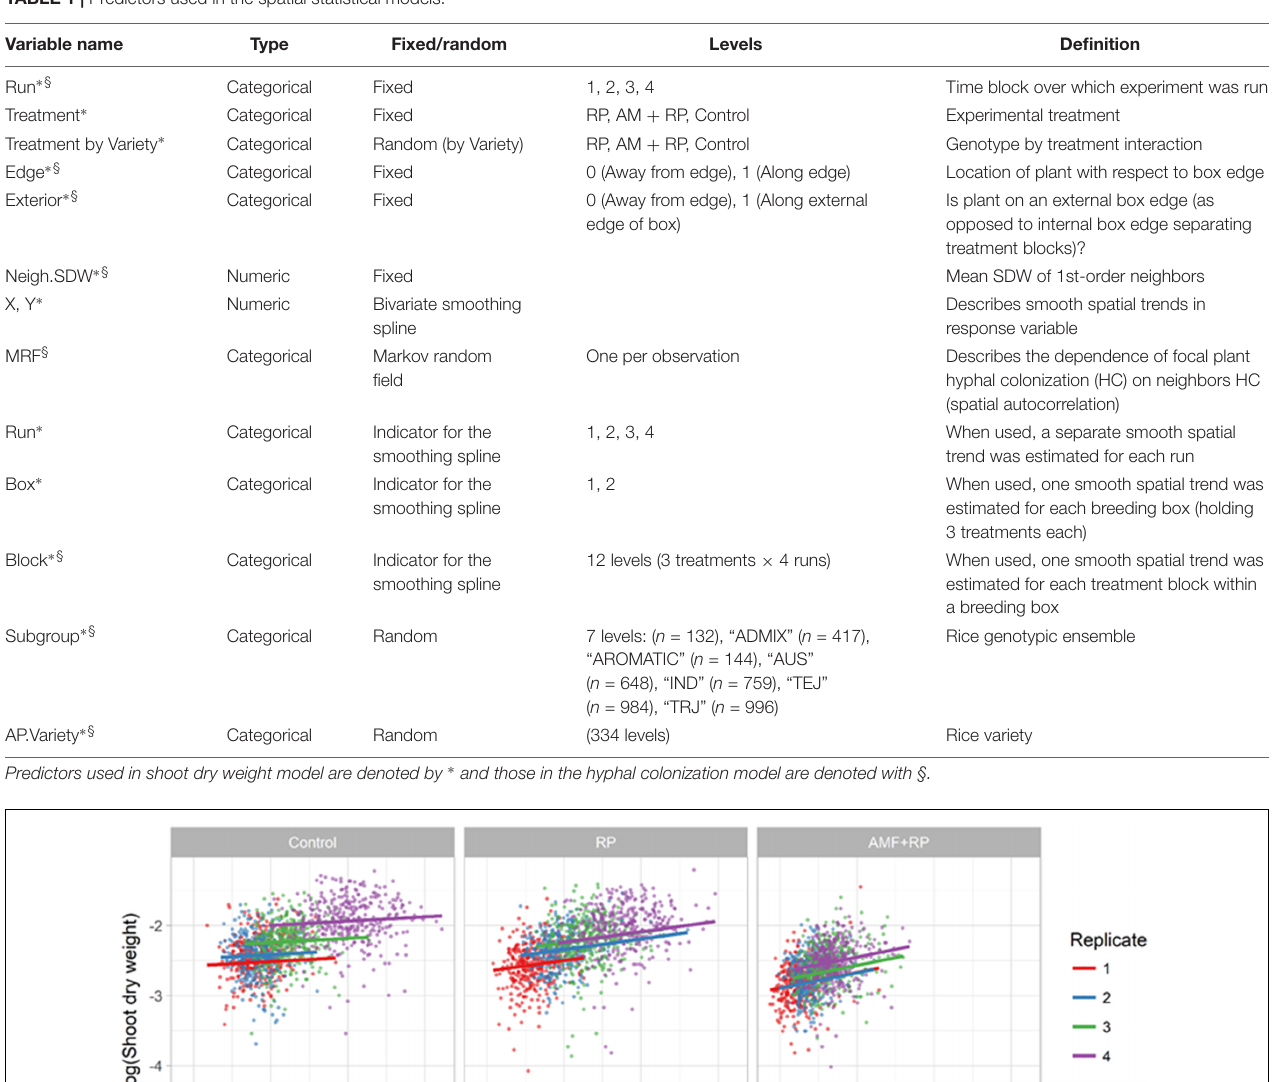
TABLE 1 | Predictors used in the spatial statistical